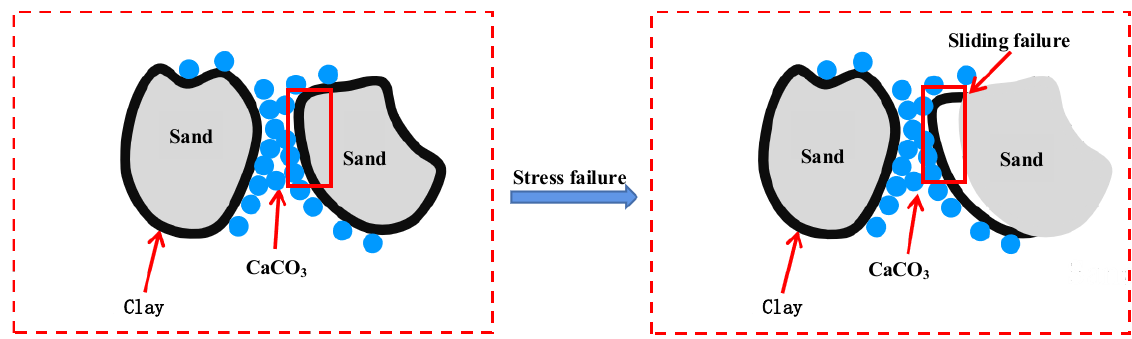
Figure 12. Average calcium carbonate content with different clay contents (MICP-Treat).